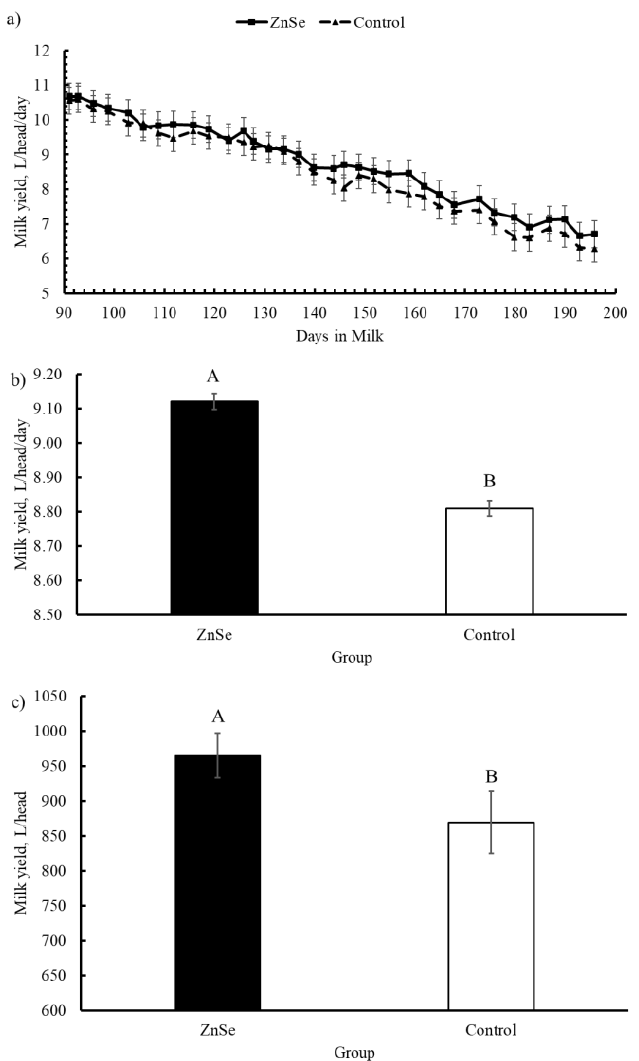
Figure 2. Milk yield trend (L/head/day) for the two groups: ( a ) changes during the trial; ( b ) average milk yield (L/head/day); ( c ) total milk yield (L/head) calculated as area under the curve. Data are expressed as Lsmeans ± SE. A,B = p < 0.001. Table 5. Results of milk quality traits, energy-corrected milk (ECM), and feed efficiency ratio (FEr) between the two groups under examination. Data are expressed as Lsmeans ± SE. a Same letters indicate no significant